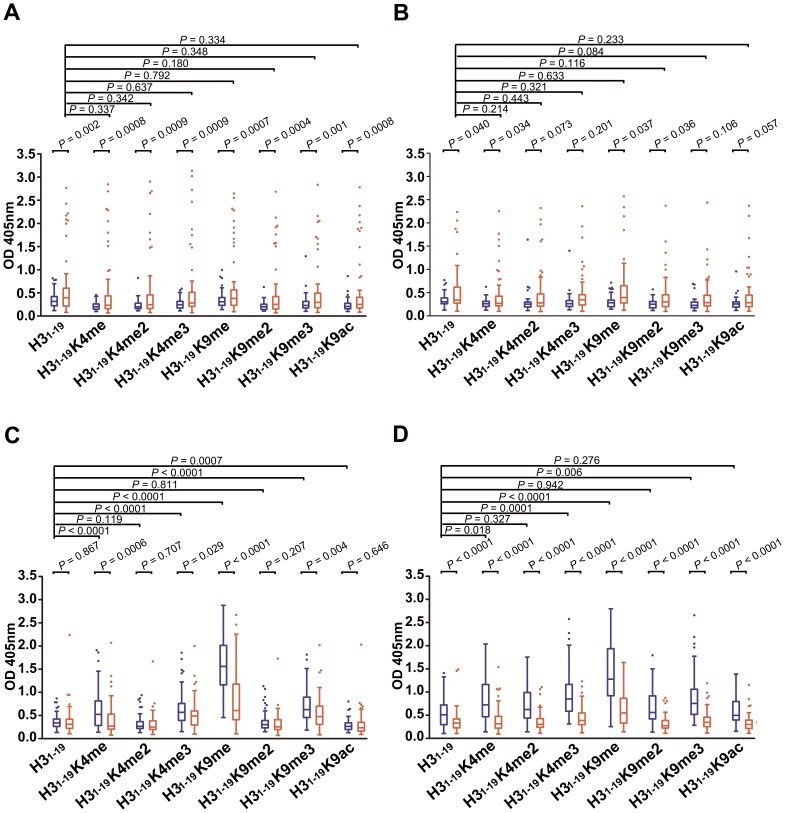
Reactivity of serum IgG and IgM against non-modified and modified H3 peptides.Microtiter plates were coated with peptides conjugated to BSA. Serum samples from healthy controls or SLE patients were diluted 1∶100 and tested. KT47 anti-human IgG and KT16 anti-human IgM mAbs were used as primary Abs, and HRP-conjugated goat anti-mouse IgG was used as a secondary Ab (see Materials and Methods). The data are presented by box-blot diagram. (A) IgG anti-peptide Abs of pediatric samples. (B) IgG anti-peptide Abs of adult samples. (C) IgM anti-peptide Abs of pediatric samples. (D) IgM anti-peptide Abs of adult samples. Healthy controls are represented in blue and SLE patients are represented in red. P values between the healthy control and SLE groups were calculated using the Student’s t test. P values within the same groups were calculated using the paired t test.